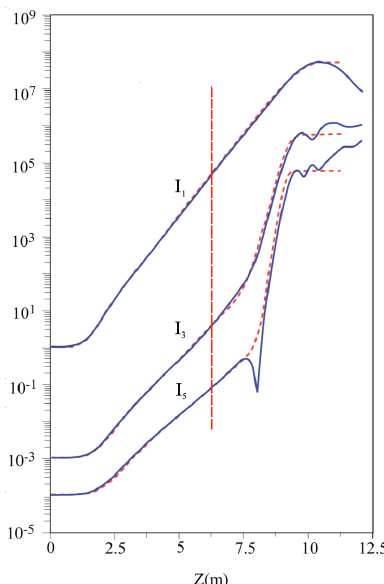
Figure 5. Harmonic evolution and nonlinear harmonic generation which is triggered after the dashed line, where the bunching effects become